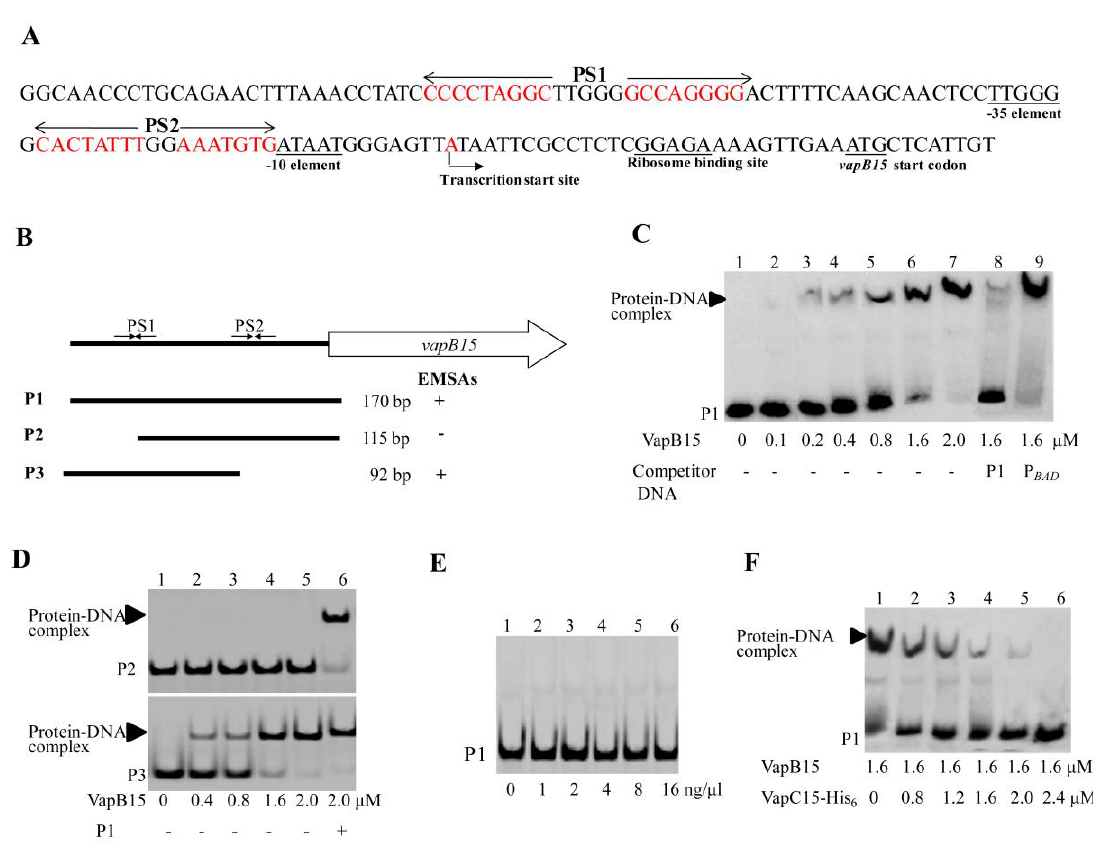
Figure 4. Electrophoretic mobility shift assays (EMSAs) for the binding of VapBC15 components to the P vapBC15 promoter. ( A ) Sequence and elements of the P vapBC15 promoter. ( B ) Schematic representation of the DNA fragments used in EMSAs. The bold lines show the relative position of the DNA fragments P1, P2 and P3. P1, P2, and P3 were prepared by polymerase chain reaction (PCR) using the primers P1-F/ssr2201-2, P2-F/ssr2201-2, and P1-F/P3-R, respectively. + or − indicates whether VapB15 binds to the DNA fragment or not. ( C ) EMSAs for the binding of VapB15 to the P vapBC15 DNA fragment. The labeled fragment P1 was incubated with the final concentrations of VapB15 as indicated below the autoradiograph. The free DNA substrate and DNA-protein complex are indicated on the left. The P BAD DNA fragment (lane 9) was obtained from pJS298 by PCR amplification using the primers P BAD -F and P BAD -R and used for nonspecific binding test. ( D ) EMSAs for the sequence required for the binding of VapB15 to the P vapBC15 DNA fragment. The labeled fragments P2 and P3 were incubated with increasing concentrations of VapB15. + or − indicates the presence or absence of the unlabeled fragment P1. ( E ) EMSAs for the binding of the VapB15-VapC15 complex to the P vapBC15 DNA fragment. The labeled fragment P1 was incubated with increasing concentrations of the VapB15-VapC15 complex. ( F ) EMSAs for the effect of VapC15 on the binding of VapB15 to the P vapBC15 DNA fragment. The labeled fragment P1 was incubated with VapB15 pre-incubated with VapC15.